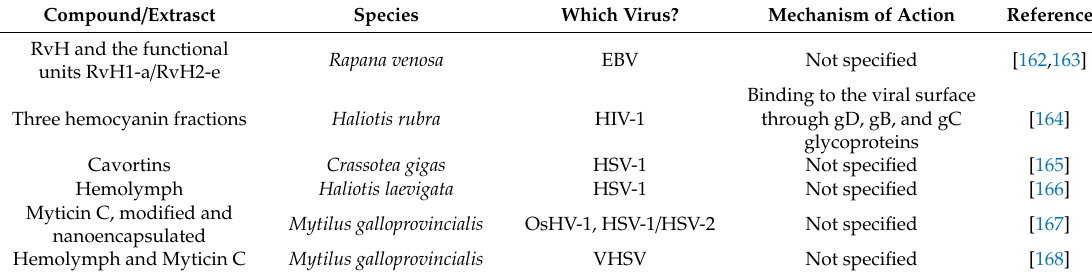
Table 7. The table report antiviral compounds / extracts from mollusks. EBV, Epstein-Barr virus; HIV-1, 2; OsHV-1, Ostreid herpesvirus 1; VHSV, Viral Hemorrhagic Septicemia